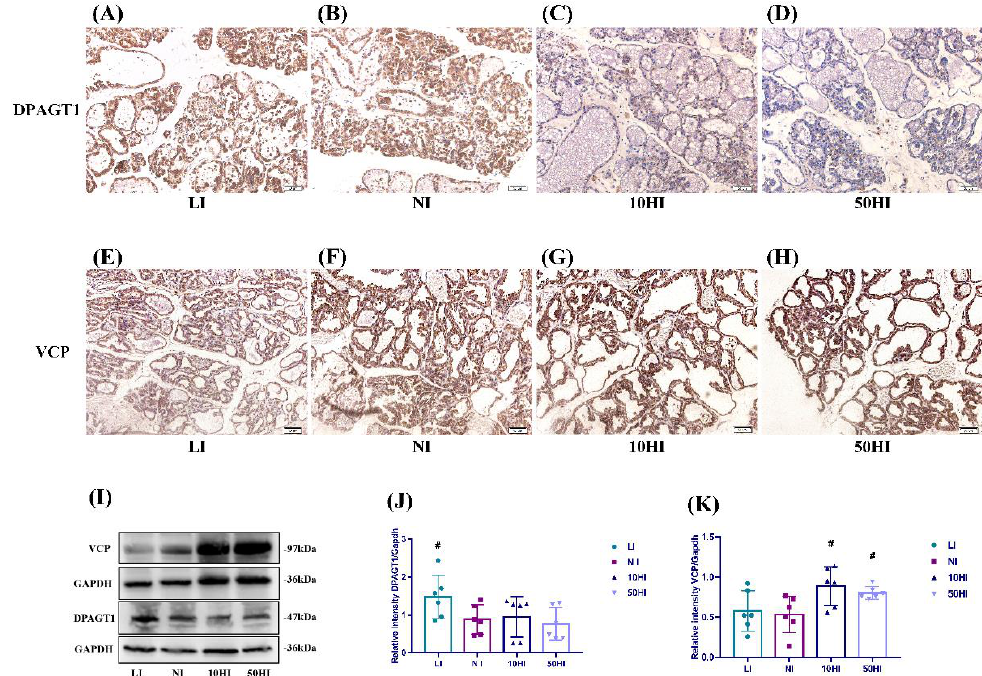
Figure 4. Localization of DPAGT1 ( A − D ) and VCP ( E − H ) in the mammary gland on the 14th day of lactation. Scale bars: 50 µ m. ( I ) Representative immunoblots of DPAGT1 and VCP. Bar graphs show the semiquantitative levels of DPAGT1 ( J ) and VCP ( K ) determined by band density analysis. (Values are shown as means ± SD. n = 6 per group. Comparisons among different groups were performed by one − way ANOVA and followed by an LSD test for multiple comparisons. # p < 0.05 compared with the NI group.)